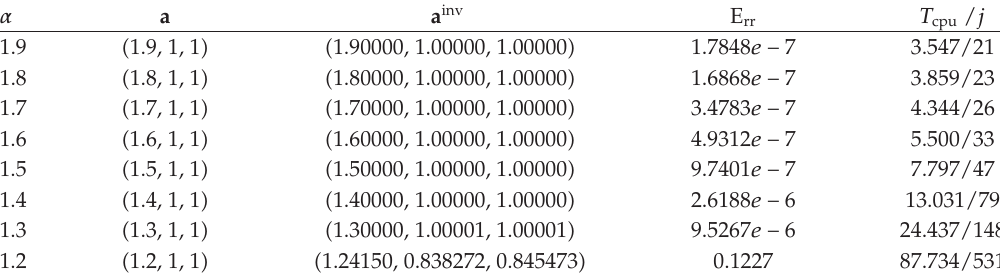
Table 6: Influence of fractional order on the inversion